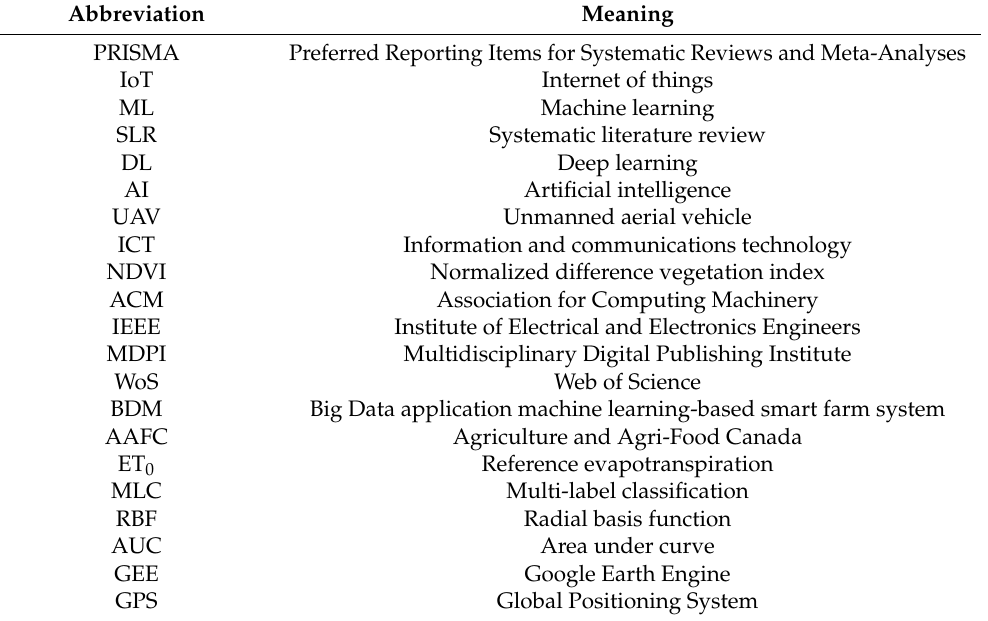
Table 2. General